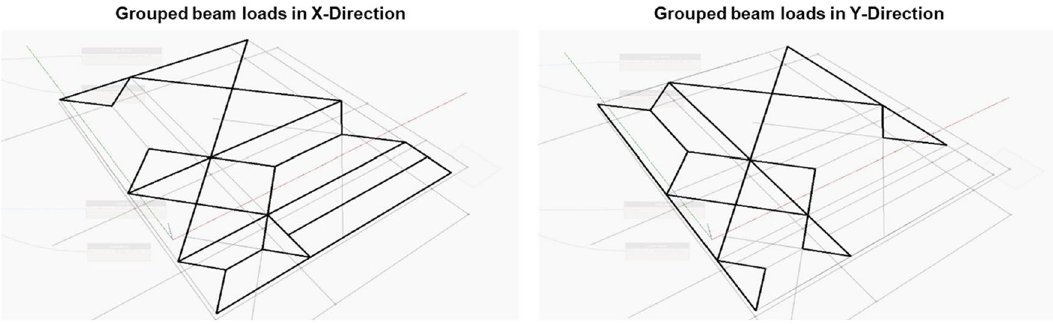
Figure 9. Grouped beam loads in the X and Y